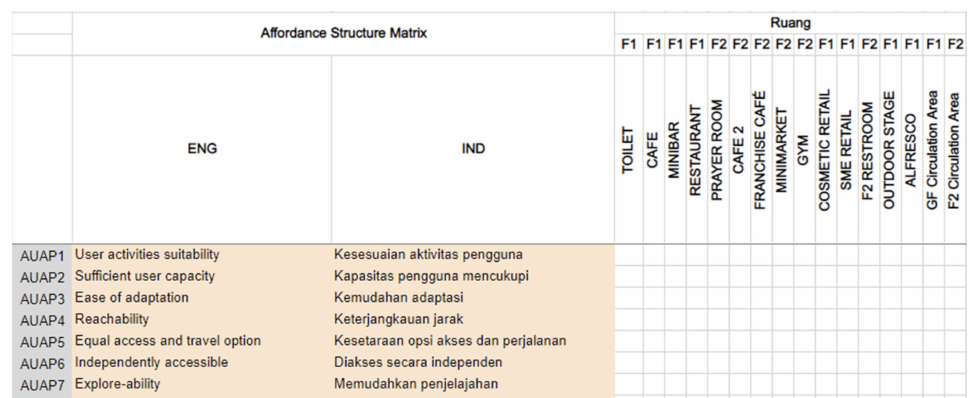
Figure 1. Affordance Structure Matrix (ASM).